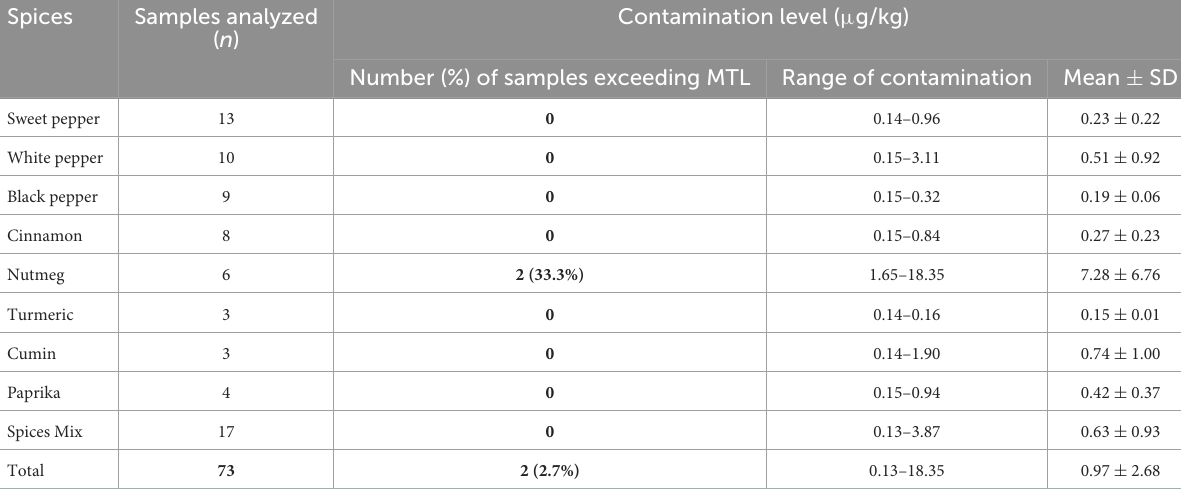
TABLE 1 Incidence and occurrence of AFB 1 in different kinds of spices in Lebanon.